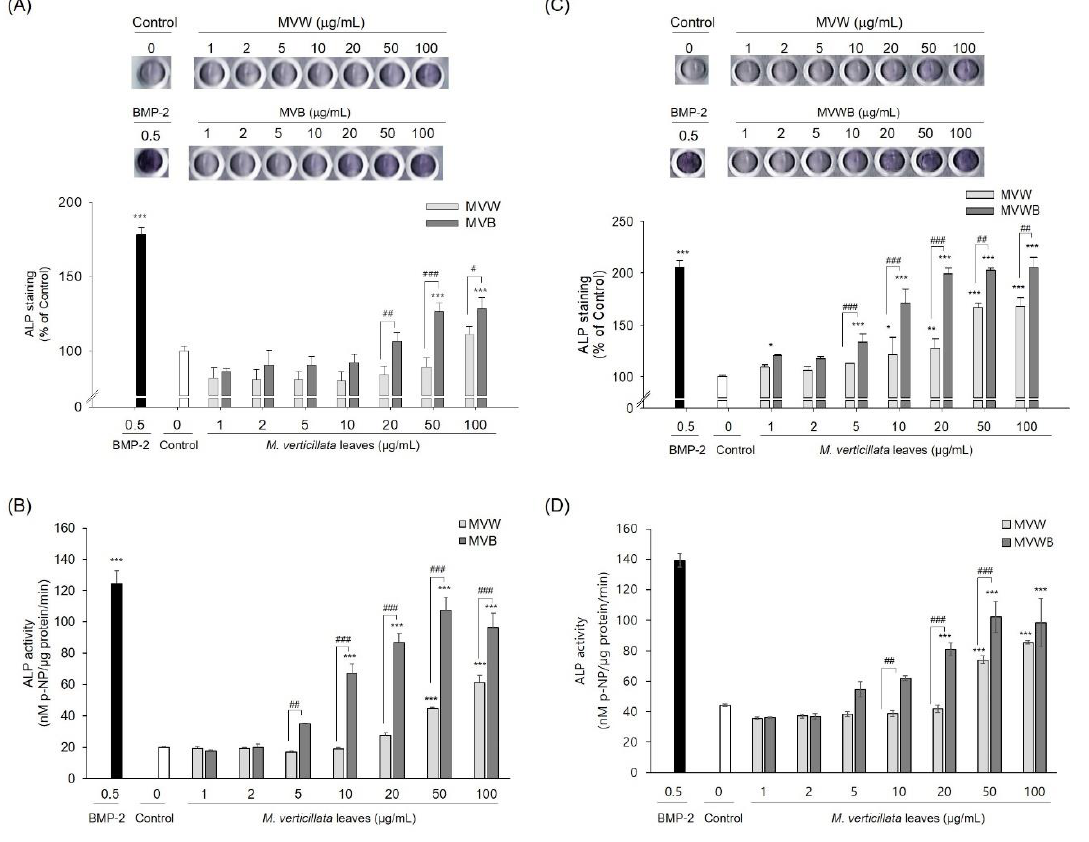
Figure 2. E ff ects of MVW, MVB, and MVWB on the alkaline phosphatase (ALP) activity of C3H10T1 / 2 cells. Visualization of the osteoblast di ff erentiation of C3H10T1 / 2 cells by MVW and MVB ( A ) and MVW and MVWB ( C ). ALP activity of C3H10T1 / 2 cells by MVW and MVB ( B ) and MVW and MVWB ( D ). MVWB: the fermented MVW by B. subtilis MV1. Significant di ff erences were observed when compared with the controls: * p < 0.05, ** p < 0.01, *** p < 0.001; significant di ff erences between MVW and MVB or MVWB were observed: # p < 0.05, ## p < 0.01, ### p < 0.001. MVW, MVB, and MVWB also induced intracellular mineralization during osteogenesis in C3H10T1 / 2 cells (Figure S4). Mineralization in the C3H10T1 / 2 cells had occurred after 21 days in culture. The intracellular mineralization of C3H10T1 / 2 cells was detected by Alizarin Red S staining, which binds to calcium to form a pigment that appears orange to red. The cells treated without the addition of M. verticillata extract were not stained, but the cells treated with MVW, MVB, MVWB, and the positive control BMP-2 were all stained red. Similar to the results of the ALP activity, cells treated with MVB and MVWB were stained red in a larger area than cells treated with MVW. This indicated that a significant amount of calcium precipitation occurred in the cells treated with MVB and MVWB.